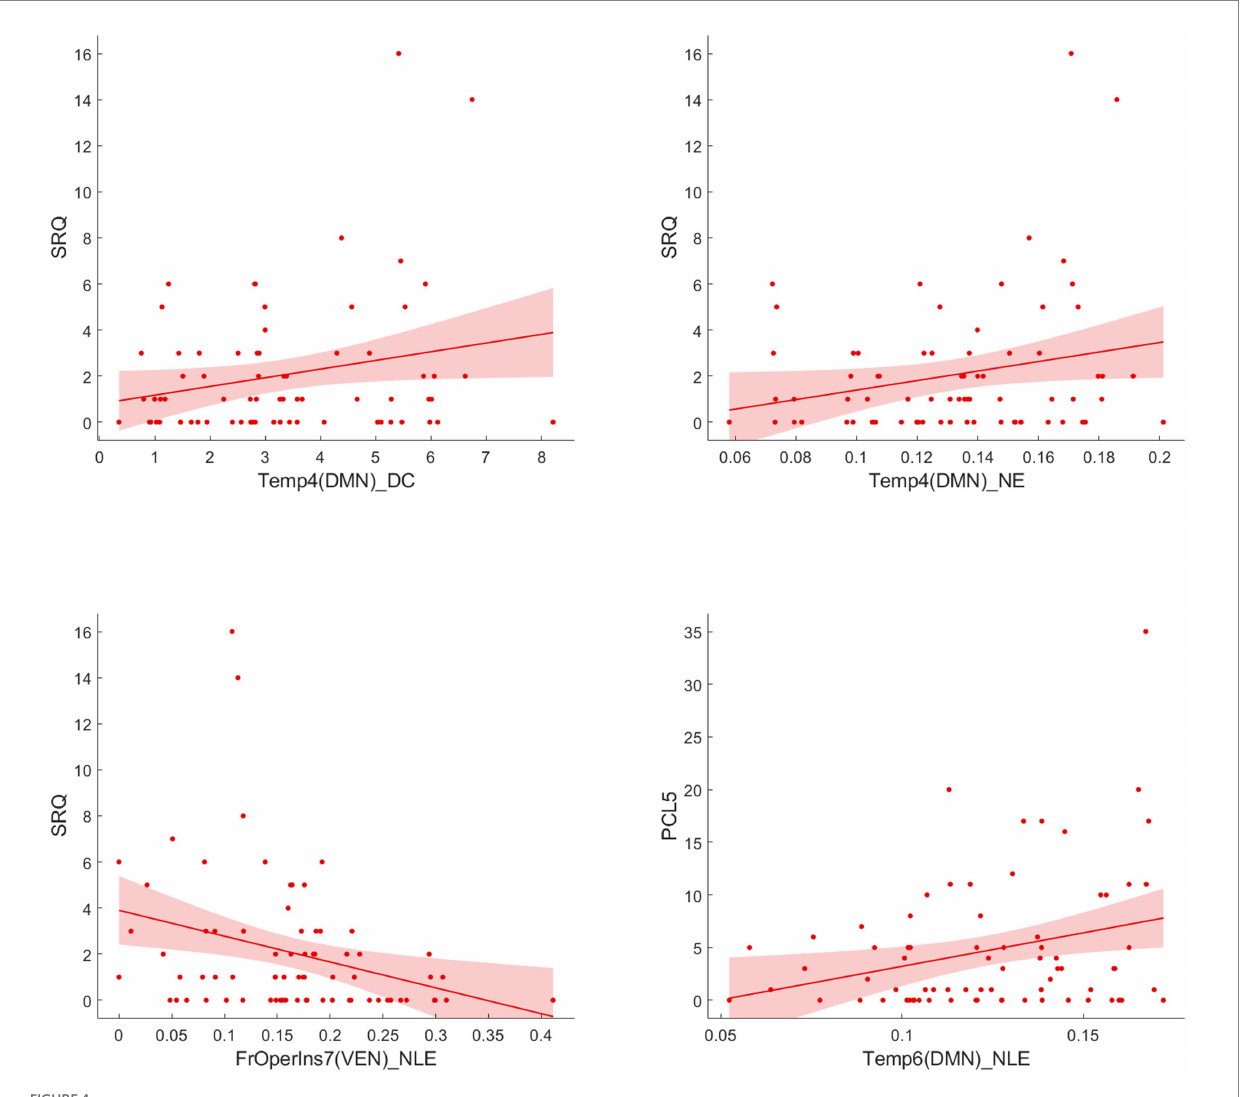
FIGURE 4 Correlation analysis between significant network metrics and clinical characteristics at